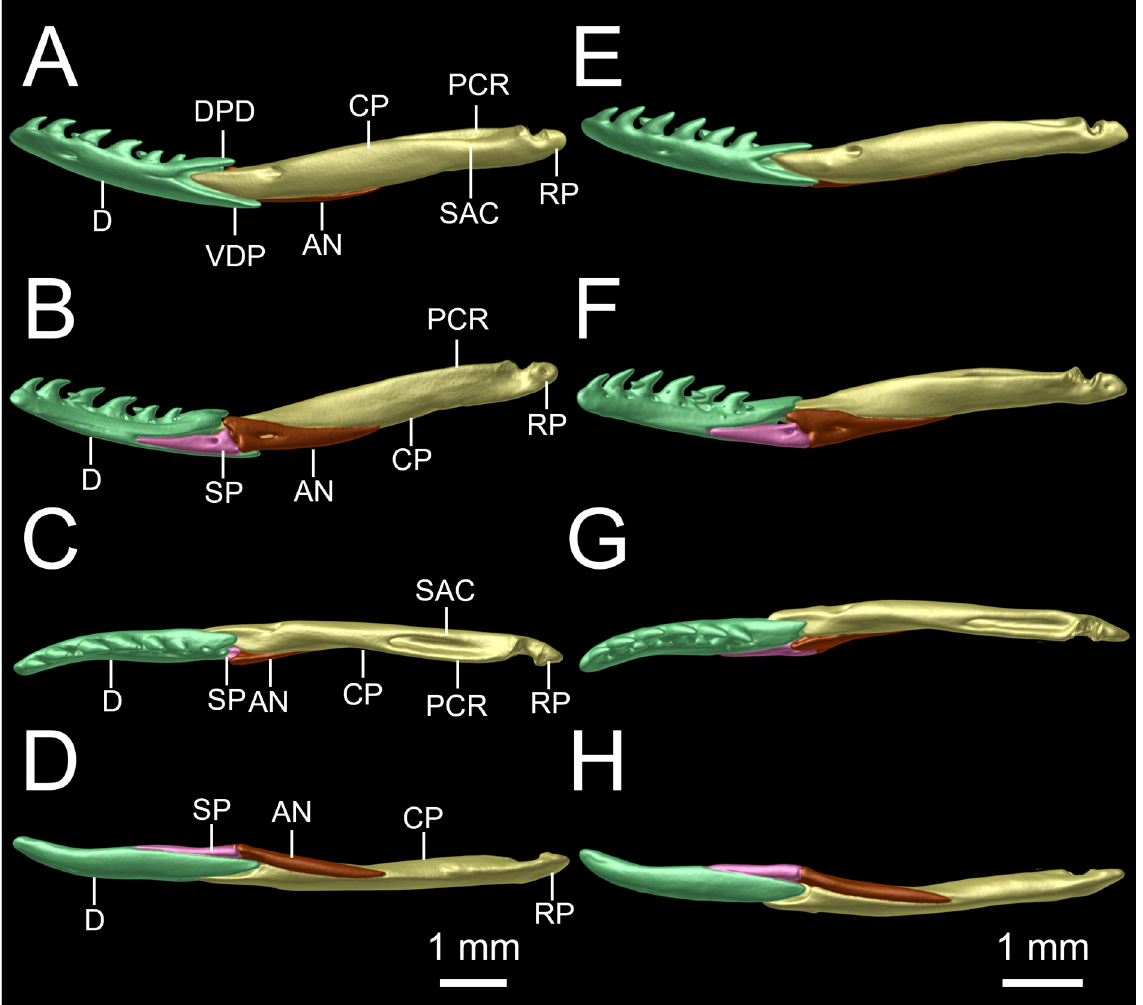
Fig. 11. Lateral (A, E), medial (B, F), dorsal (C, G), and ventral (D, H) views of the lower jaw based on μCT imagery. A–D . Apostolepis albicollaris Lema, 2002, holotype (MCP 8355). E–H . A. cerradoensis visualization. Abbreviations: AN = angular; CP = compound bone; D = dentary; DPD = dorsal